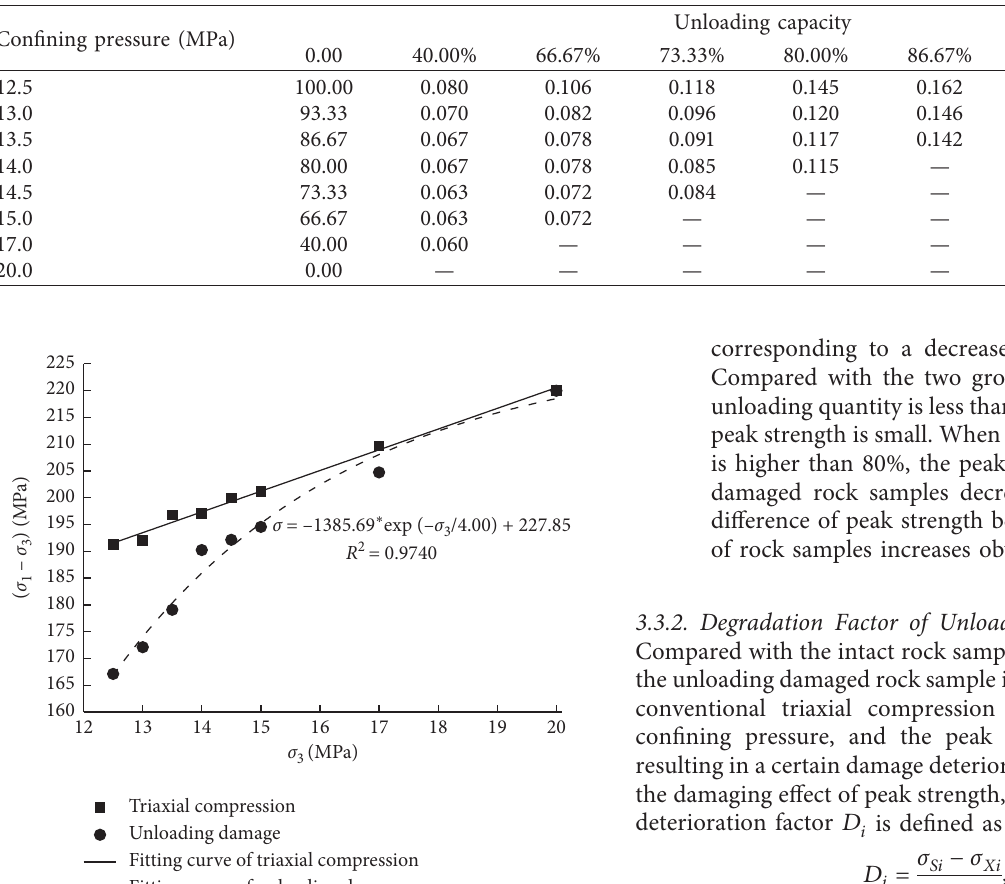
Table 1: Compliance statistics of strain confining pressure.